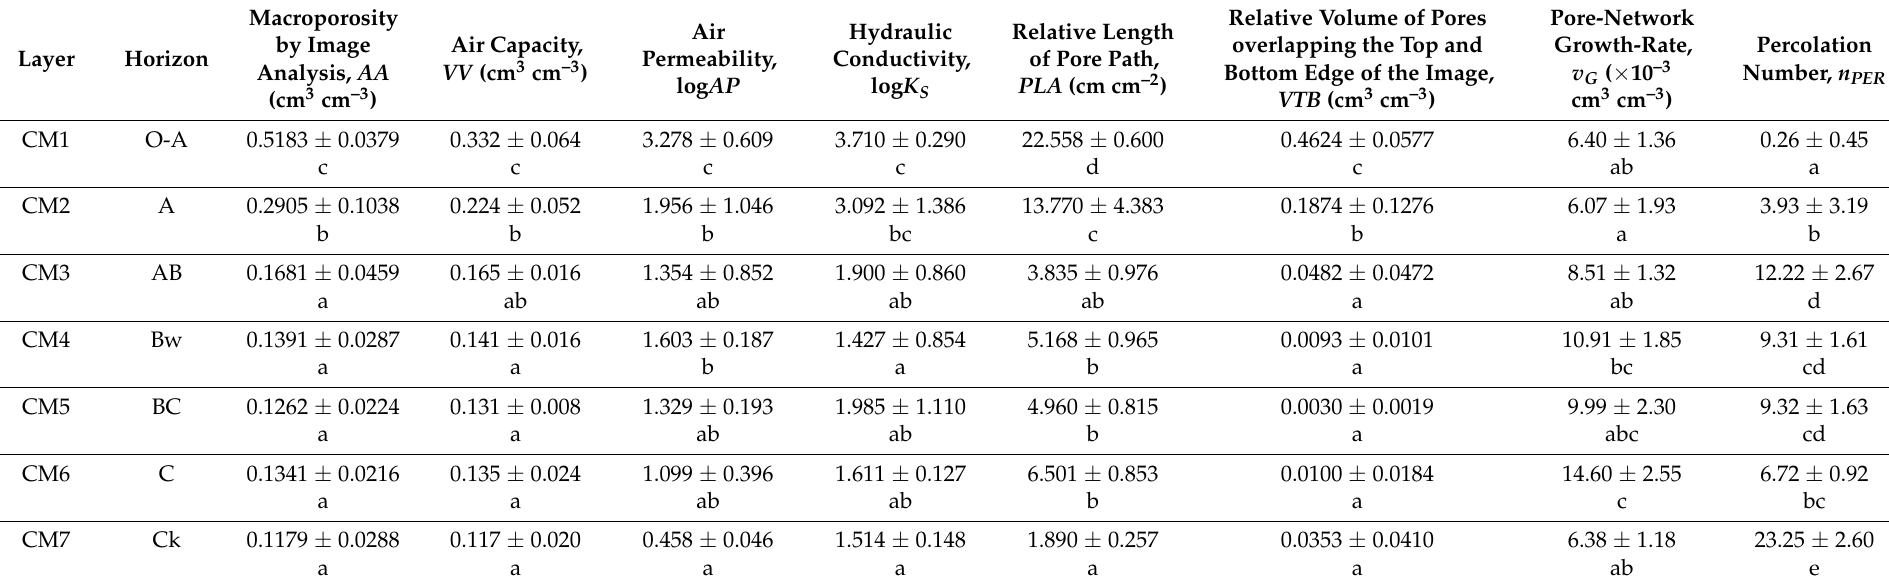
Table 2. Water and air properties and morphometric parameters for the studied Cambisol. Results of 1-way ANOVA; for each parameter, different letters denote statistically different values between layers at p < 0.05 according to Tukey’s honestly significant difference